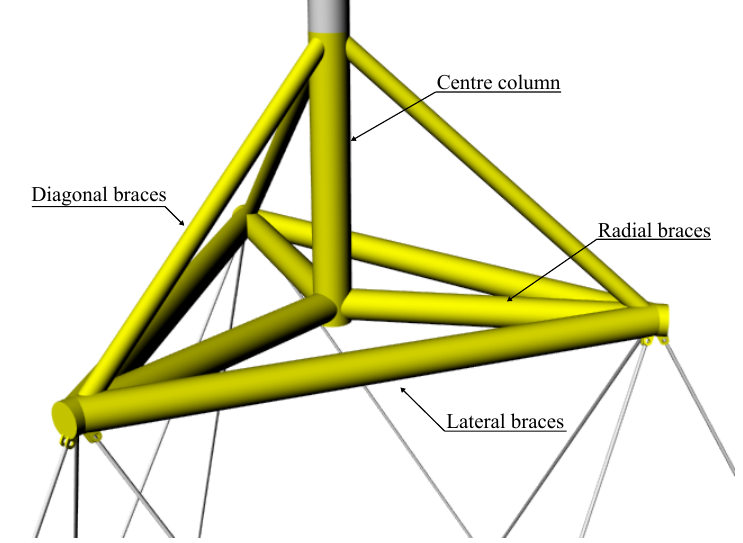
Figure 4. Naming of floater subcomponents. Table 4. Properties of the